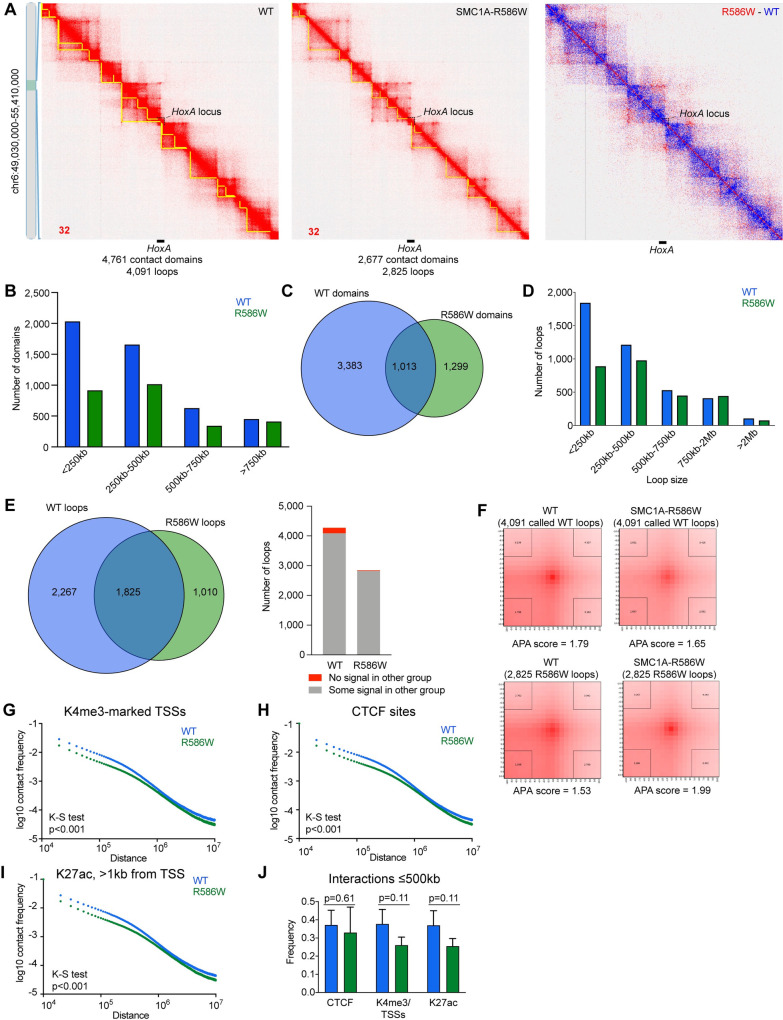
Altered chromatin looping in SMC1A-R586W mESCs.A Hi-C heatmaps at 10kb resolution centered around the HoxA locus in wildtype and R586W mESCs. Yellow lines indicate positions of contact domains called by Arrowhead in each. B Distribution of contact domains by size in WT and SMC1A-R586W mESCs. C Overlap of domain positions in WT and SMC1A-R586W mESCs. D Distribution of loops by size in WT and SMC1A-R586W mESCs. E Left, overlap of loop positions between wildtype and R586W mESCs as measured by Juicer Tools CompareLists routine. Right, overlap of loop positions as measured by Juicer Tools HICCUPsDiff routine F Aggregate peak analysis (APA) in wildtype and R586W mESCs, at wildtype loops (top row) or R586W loops (bottom row). p<0.05 as measured by Kruskal-Wallis test with Dunn’s multiple comparisons correction for wildtype vs R586W when APA is determined at wildtype loop calls (top row), and wildtype vs R586W when APA is determined at R586W loop calls (bottom row). G Distribution of contact distances with K4me3-marked TSSs, H CTCF sites, or I TSS-distal K27ac sites in WT and SMC1A-R586W mESCs. Line is mean of two replicates in each group. Statistical significance tested using Kolmogorov-Smirnoff test. J Binned interactions under 500kb with given genomic feature. Bars represent mean±s.d. for each group. Differences n.s. as measured by two-way ANOVA.